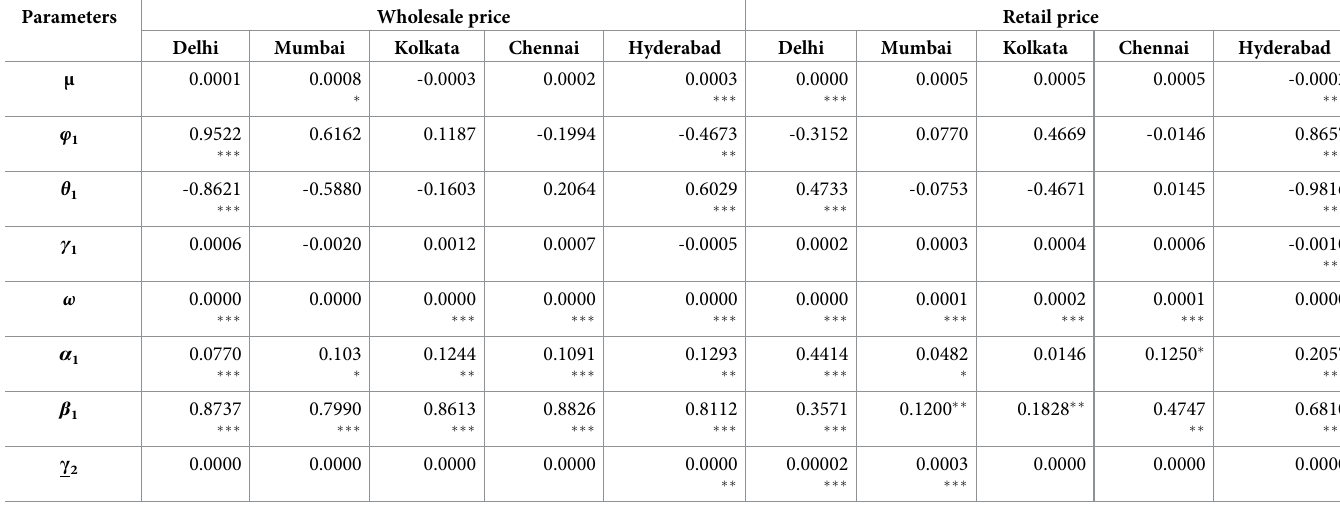
Table 2. Parameters estimate of GARCH-X model for arhar.